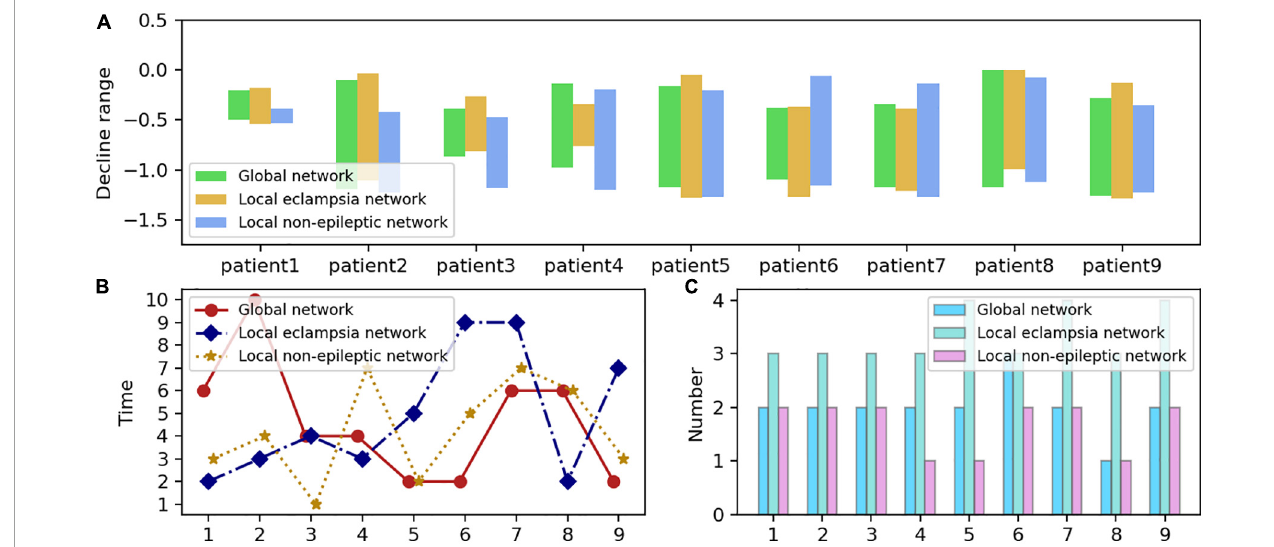
FIGURE7 Distribution of neural network sizes in nine epilepsy patients. (A) The H sb plunge interval for each network size is formed by the highest and lowest values of the blue curve in each subplot of Figure 6 , which corresponds to the length of each bar. The y-axis value corresponding to the bottom of each bar on the graph is the blue curve, which represents the most negligible value of H sb , while the top represents the highest value of H sb . The x-axis represents the patient number, and the y-axis measures the interval maximums and minimums with the interval lengths. (B) Periods during which high-intensity oscillations occur in networks of various sizes, namely, the most significant decrease followed by a rebound in each subplot of Figure 6 ’s blue dashed line. In the graph, the three colors reflect the three network types, the x-axis represents the patient number, and the y-axis denotes the precise time during which the steepest drop occurred, numbered as in Figure 6 to represent separate seizure episodes. (C) The frequency of high-intensity oscillations in the various networks, mainly the frequency of the blue dash’s descent and subsequent rebound in each subplot of Figure 6 . The x-axis represents the number of patients, while the y-axis displays the